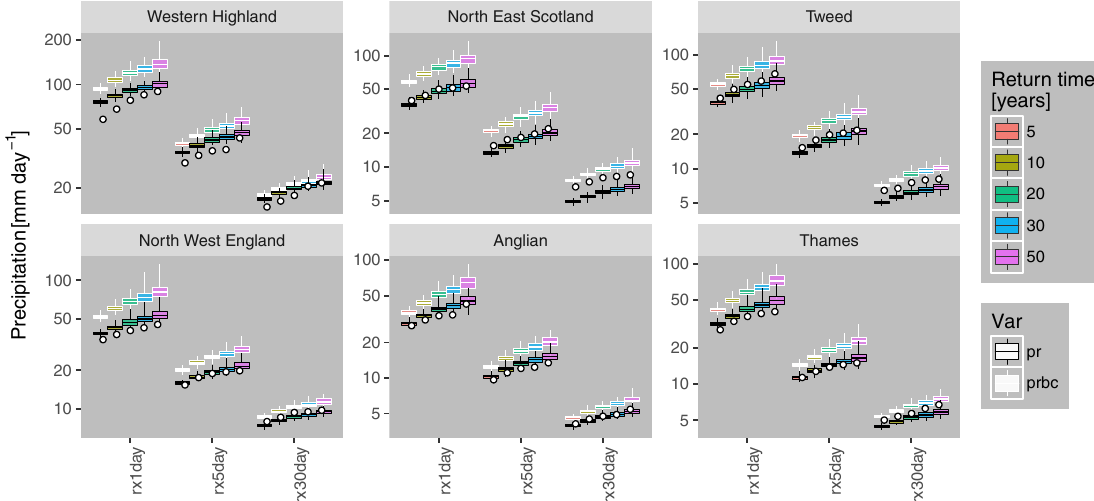
Figure 9. Return values of high-precipitation indices rx1day, rx5day and rx30day ( x axis) in the 100 baseline time series (box plot) and in CEH-GEAR (white dot) for each region (panel), for return times of 5–50 years (colour). Bias-corrected precipitation data are boxed in white (raw precipitation data in black). Whiskers display the range from individual time series. Note that for these metrics, the raw precipitation data compares better to observations than bias-corrected values. See Fig. S12 for the plots for all